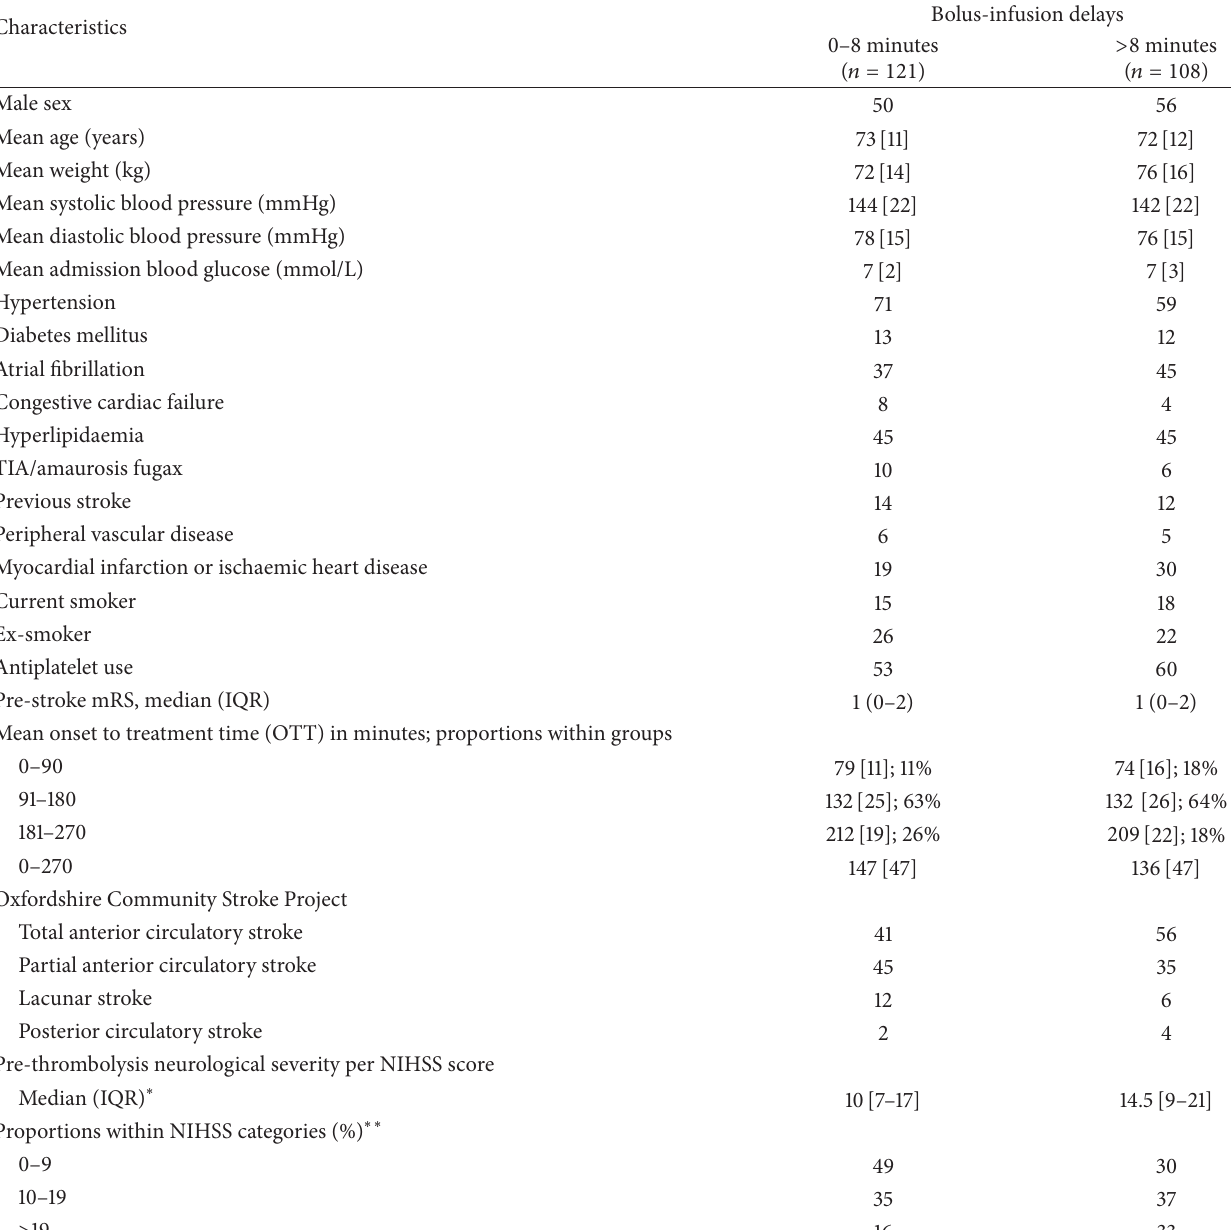
Table 1: Demographic and clinical characteristics of patients. Data presented as mean [SD] for continuous variables and proportions (%) for categorical variables unless otherwise